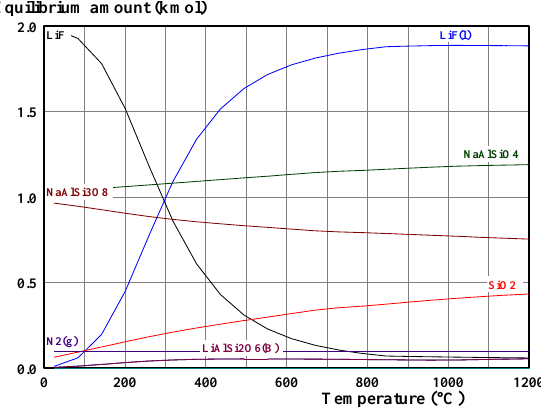
Figure 6. Equilibrium amounts versus temperature for carbonizing roasting of spodumene using Na 2 CO 3 by considering reactions reported in ( a ) Equation (12) and in ( b ) Equation (13), leading to the formation of Li 2 O and Li 2 CO 3 , respectively (data from HSC Chemistry 5.1 software). Figure 7. Equilibrium amounts versus temperature for fluorination roasting of spodumene using NaF (data from HSC Chemistry 5.1 software).